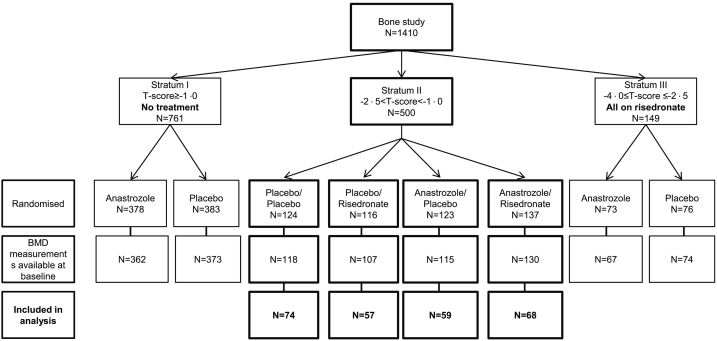
CONSORT diagram of enrolled women and BMD data included in this analysis.